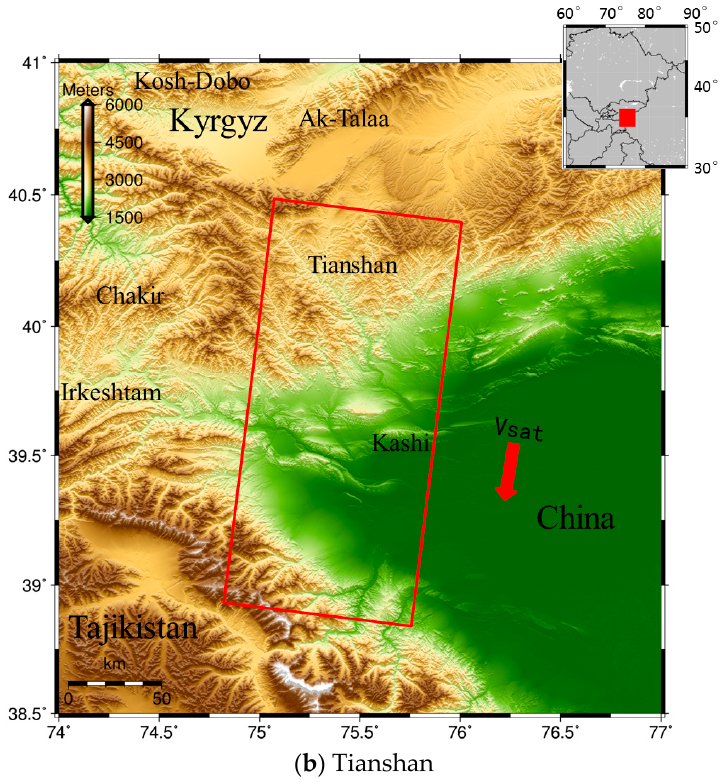
Figure 1. InSAR data coverage for: ( a ) California; and ( b ) Tianshan. The background is the SRTM DEM. Black polygons indicate the illuminated ground area of the entire SAR image and red polygons represent our study regions. The black circular markers indicate the center of multiple windows used for the PLE method. The blue dashed and solid lines indicate the moving windows. Windows are arranged in an ascending manner and start in the lower left corner. These windows within a tropospheric region constrain the delay estimation by a 50% overlap. Table 1. Parameters of ENVISAT ASAR interferograms.